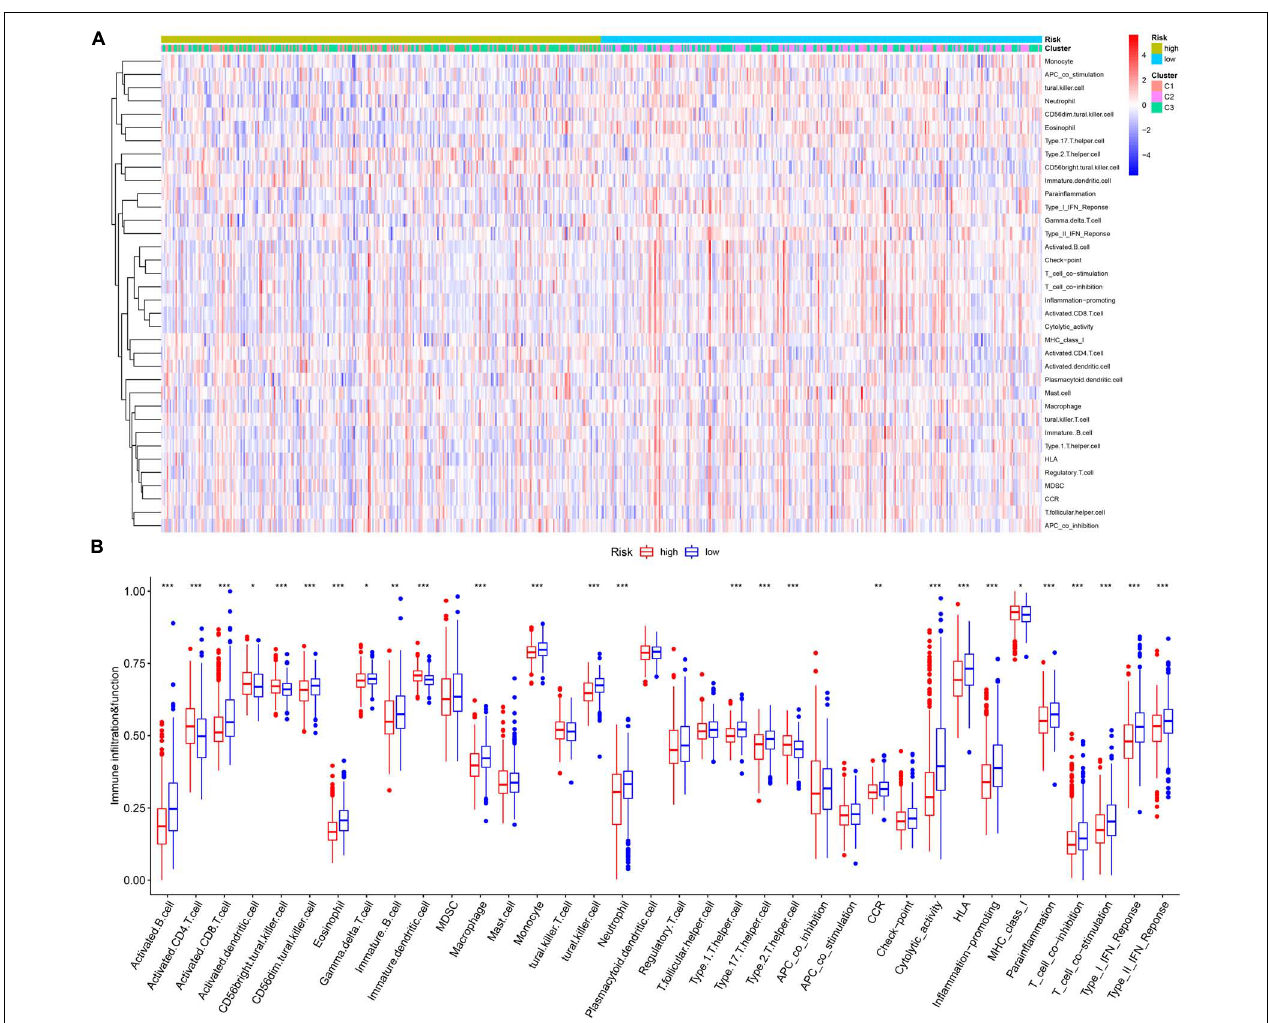
FIGURE 7 | The landscape of tumor immune microenvironment in the training cohort. (A) The heatmap. (B) The boxplot of the TIME difference between high- and low-risk groups. * p < 0.05, ** p < 0.01, *** p <